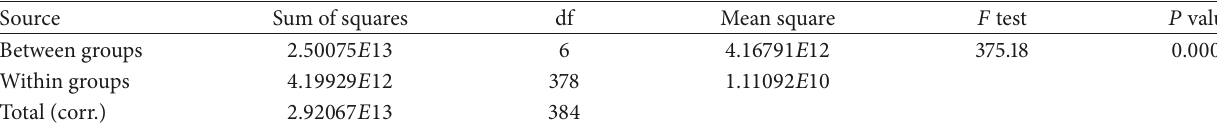
Table 6: ANOVA cost per